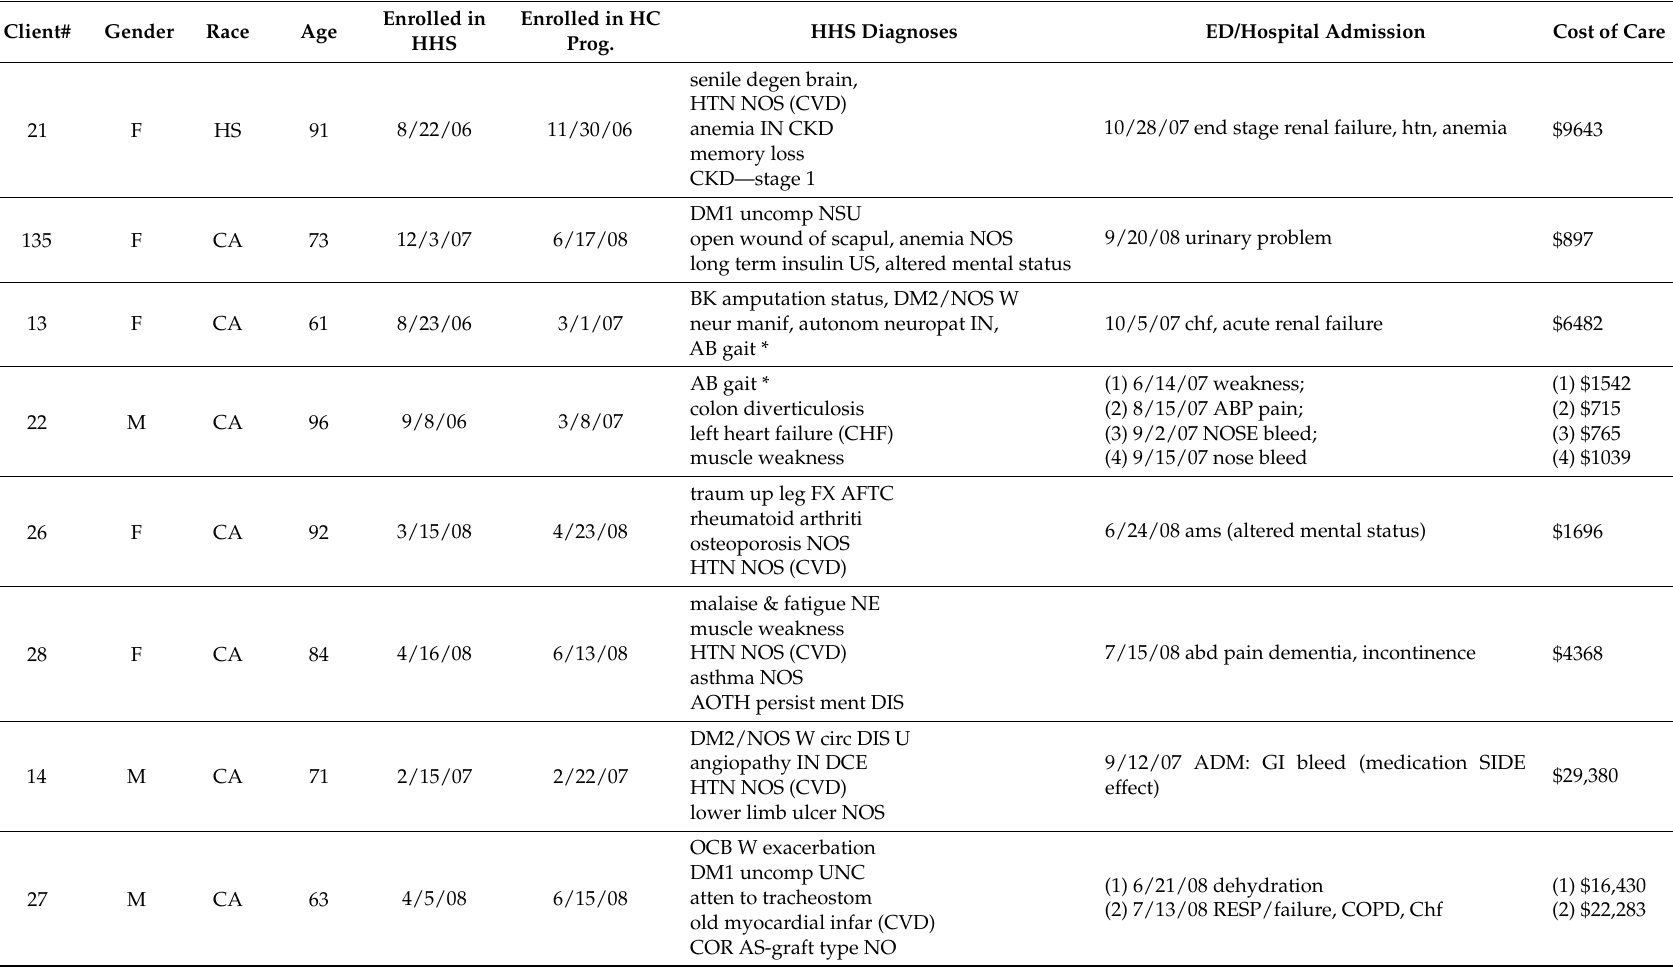
Table 3. Gender, Race, Age, HHS Diagnoses, HHS and HC Enrollment Dates, Causes and Costs of Emergent Care of Health Coach Clients ( N = 14/33, 42.4%).